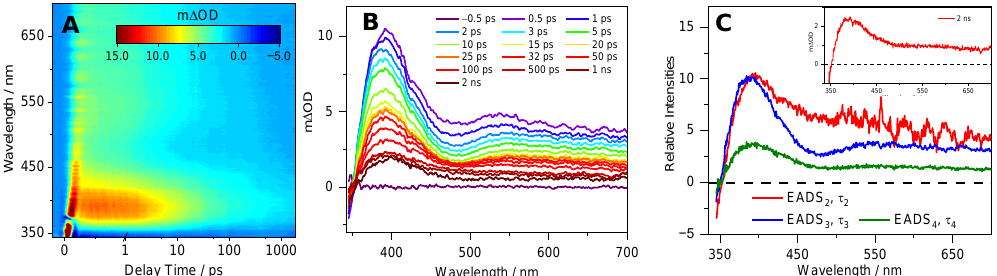
Figure 4. TEA spectra obtained for the bulk solution of Detoxophane nc photoexcited at 330 nm, shown as a false colour map ( A ). The same data are presented as a line plot of the mΔOD vs. probe wavelength at selected pump–probe delay times in ( B ). The EADS is shown in ( C ), with the 2 ns transients presented as an inset.